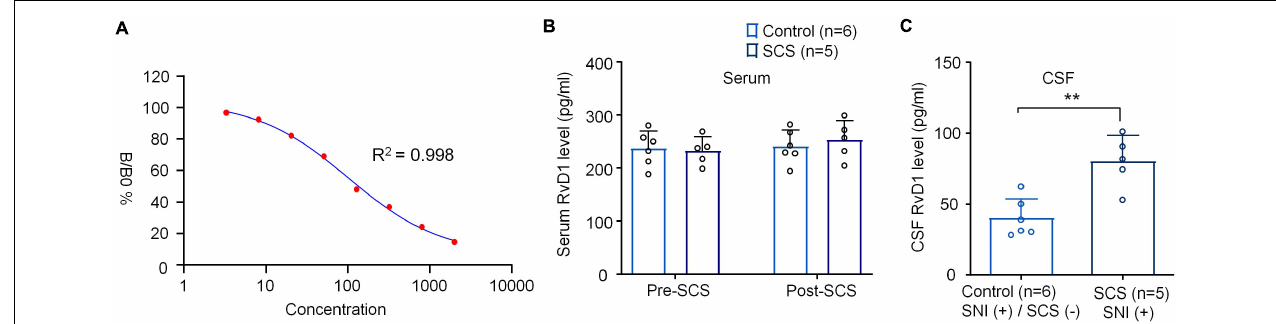
FIGURE 4 | SCS at 1 kHz increases RvD1 levels in CSF samples from SNI rats. (A) Standard curve of RvD1 ELISA. R 2 = 0.998. (B,C) Effects of 1 kHz SCS (80% MoT) on RvD1 levels in (B) serum and (C) CSF. ** p < 0.01, two-tailed Student’s T -test (C) . The sample sizes (number of rats per group) are indicated in each panel. Control = SNI ( + )/SCS ( −